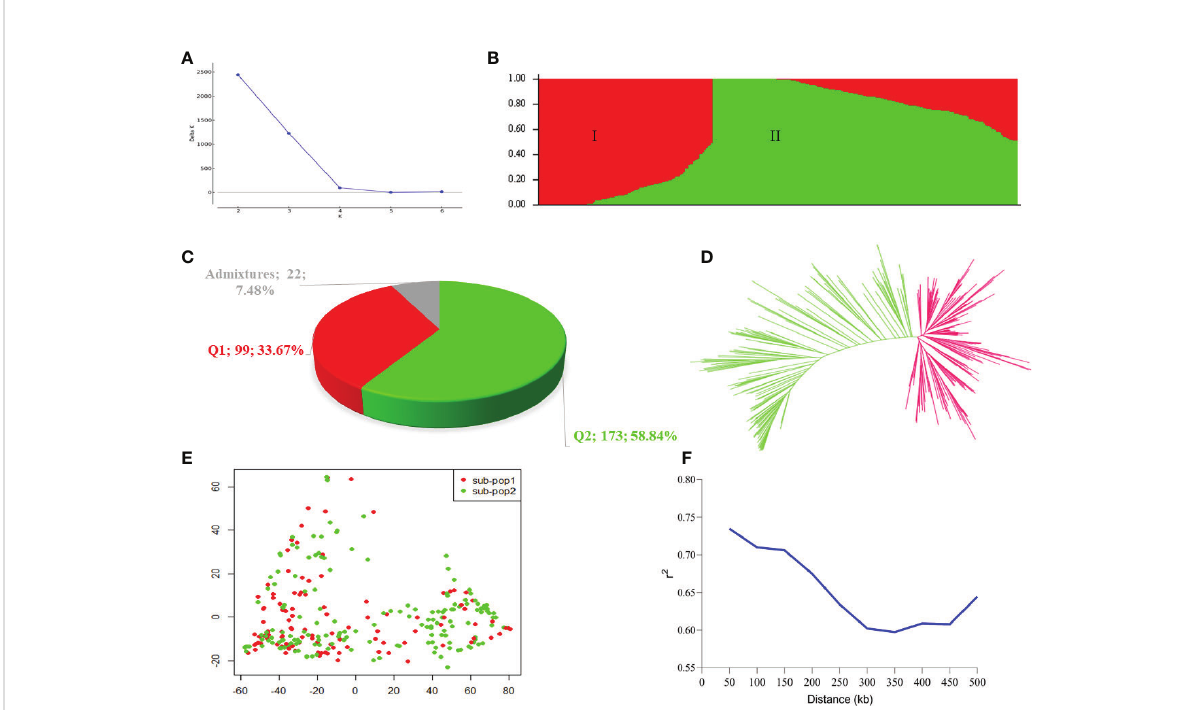
FIGURE 2 Population strati fi cation of the 294 accessions in this study. (A) Estimated D K in the population structure analysis retrieved from STRUCTURE HARVESTER online programme. (B) Population structure by STRUCTURE software. The two colours (red and green) represent two sub-populations. Each colour represent one inferred ancestral population with the vertical column representing one individual accession and coloured segment in each column denotes percentage of the individual inferred ancestral population in the studied panel. (C) Proportion of pure and admixture lines based on membership coef fi cients (Q) ≥ 0.60 as pure lines, while those with Q< 0.60 considered as admixture lines. (D) A neigbour-joining phylogenetic tress. (E) Principal component analysis plot. (F) Linkage disequilibrium decay plot within the 500 kb across the two sub-genomes (A, B)